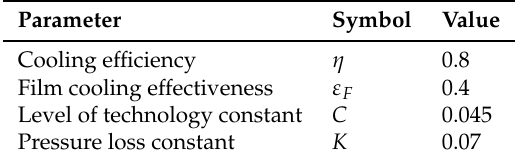
Table 1. Cooling system model parameters. Values taken from